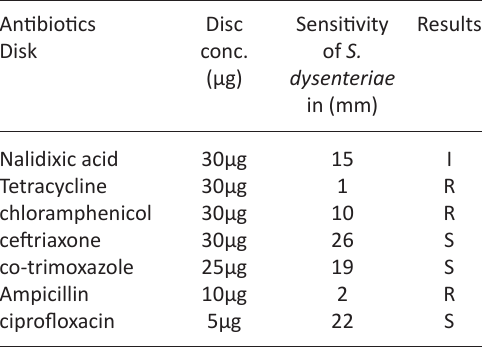
Table 3. The antibiotics susceptibility